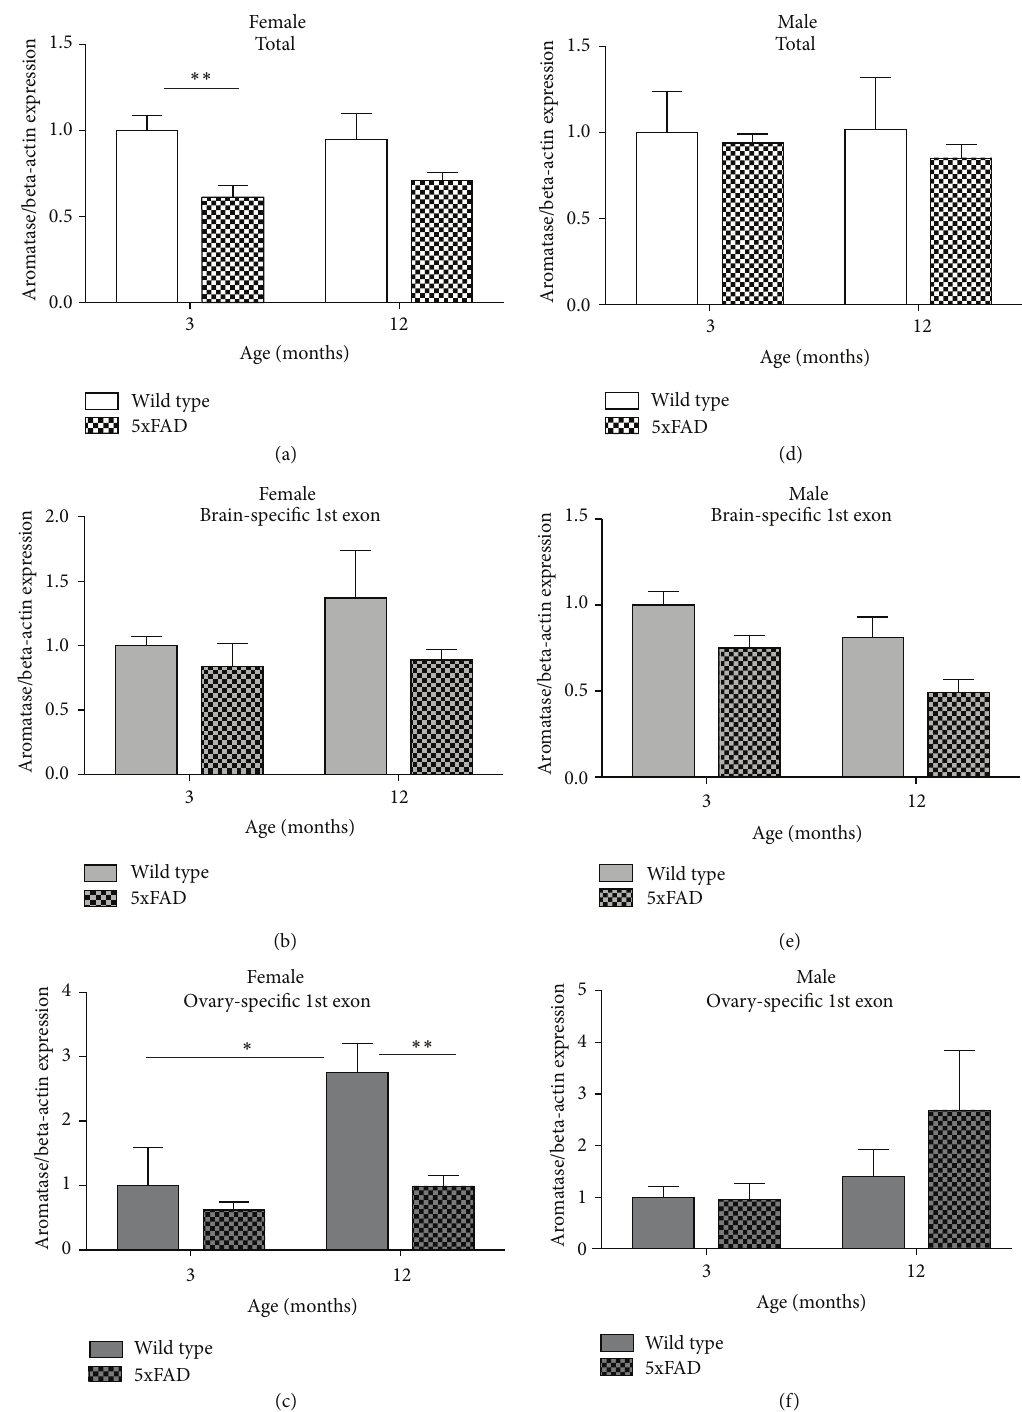
Figure 4: Aromatase mRNA expression differed in hippocampi of female and male 5xFAD mice and first exon-specific aromatase expression changed with age . In the hippocampi of female mice, the total aromatase expression was lower in the 5xFAD mice, with a significant difference in the 3-month-old animals (a), whereas no such difference was detectable in male animals (d). Expression of the tissue-specific first exons did not differ significantly in the male hippocampi, neither between the genotypes nor over time (e, f). In female mice, the expression of the ovary-specific first exon was significantly higher in the 12-month-old WT animals compared to the 3-month-old WT animals and the 12- month-old 5xFAD mice (c). However, expression of the brain-specific first exon did not differ significantly in the female mice (b) ( ∗ 𝑝 ≤ 0.05 , ∗∗ 𝑝 ≤ 0.01 ; bars represent mean ± SEM, 𝑛 = 6